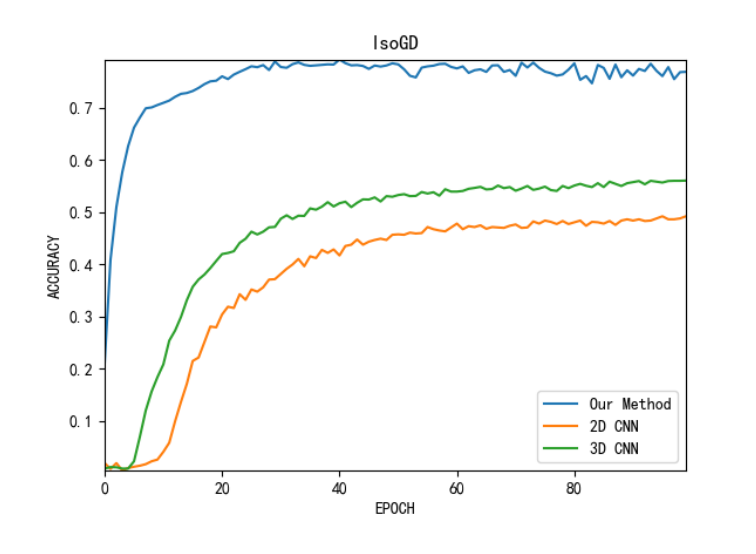
Figure 5. Accuracy comparison on IsoGD using mainstream